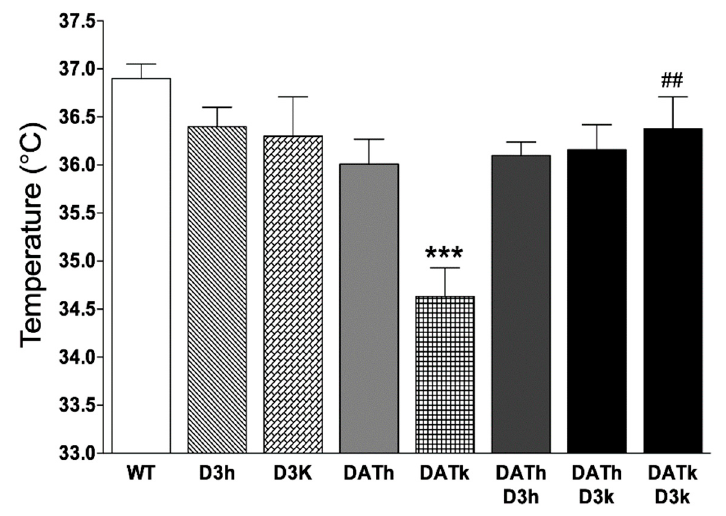
Figure 2. The body temperature of wild type, DAT, and D3 single mutants and DAT / D3 double mutants. Values represented in mean ± S.E.M in °C. *** p < 0.001 vs. WT controls, ## p < 0.01 vs. DAT knockout (DATk) group.